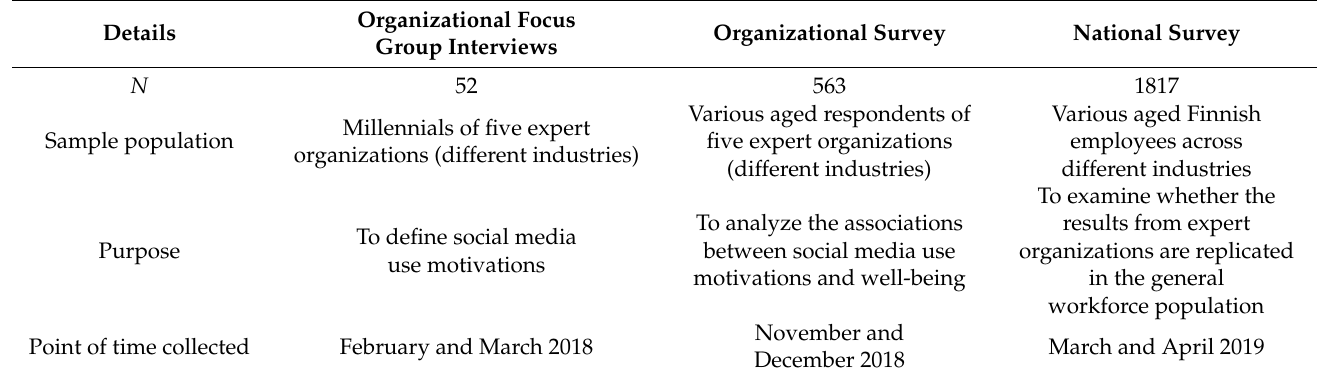
Table 1. Study participants, data, and